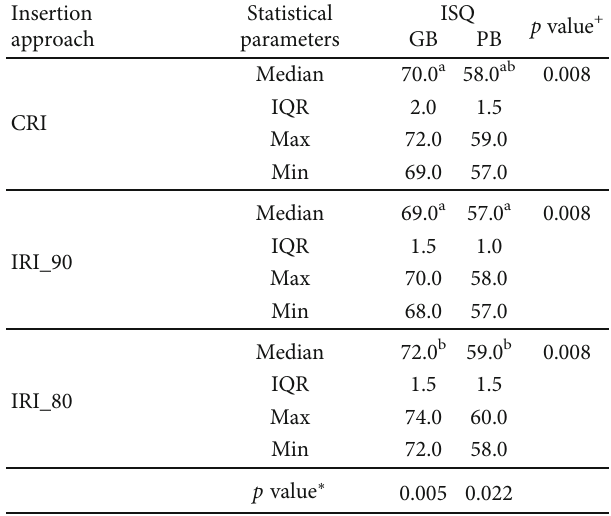
Table 2: ISQ of the three insertion approaches for GB and PB. Insertion approach